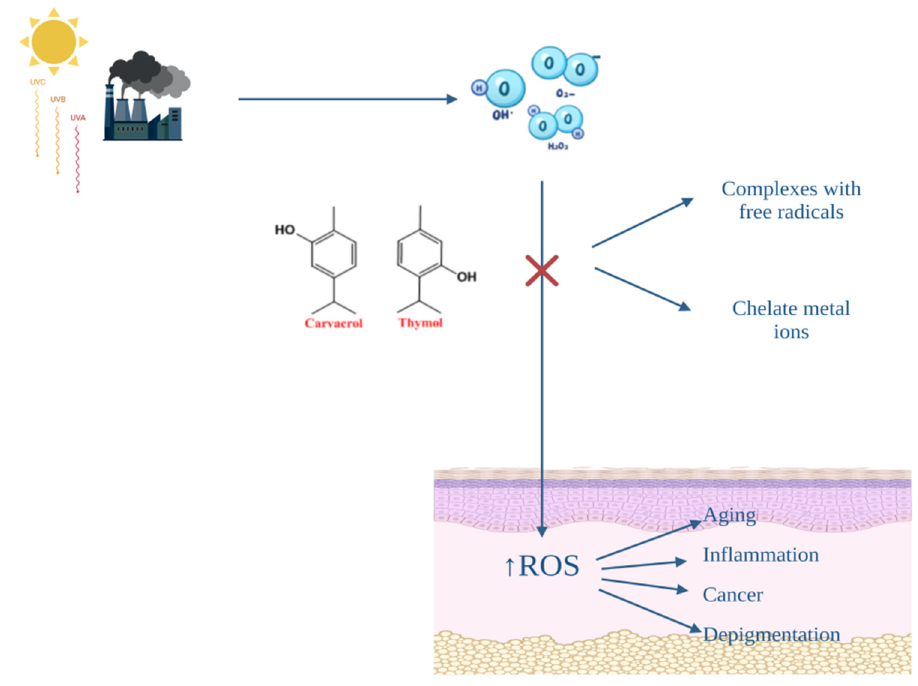
Figure 4. A snapshot of the antioxidant effect of